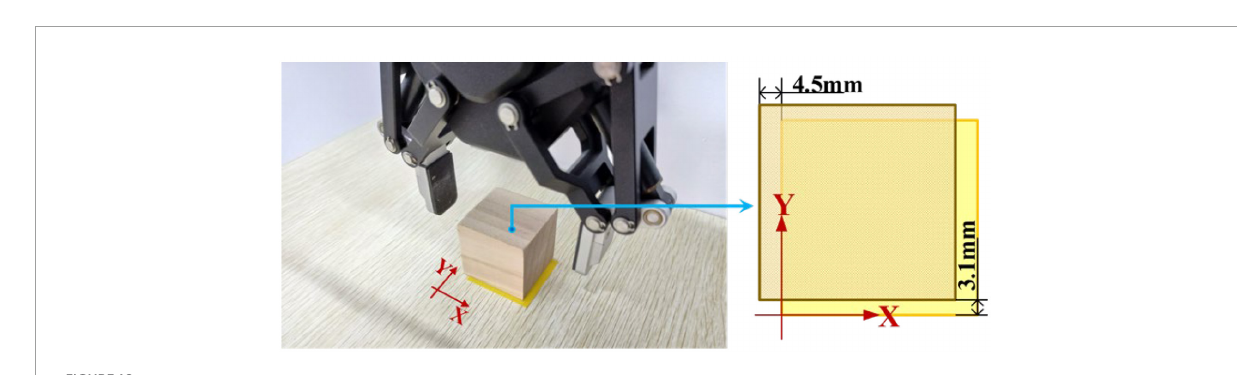
FIGURE18 The illustration for placement deviation in Task one